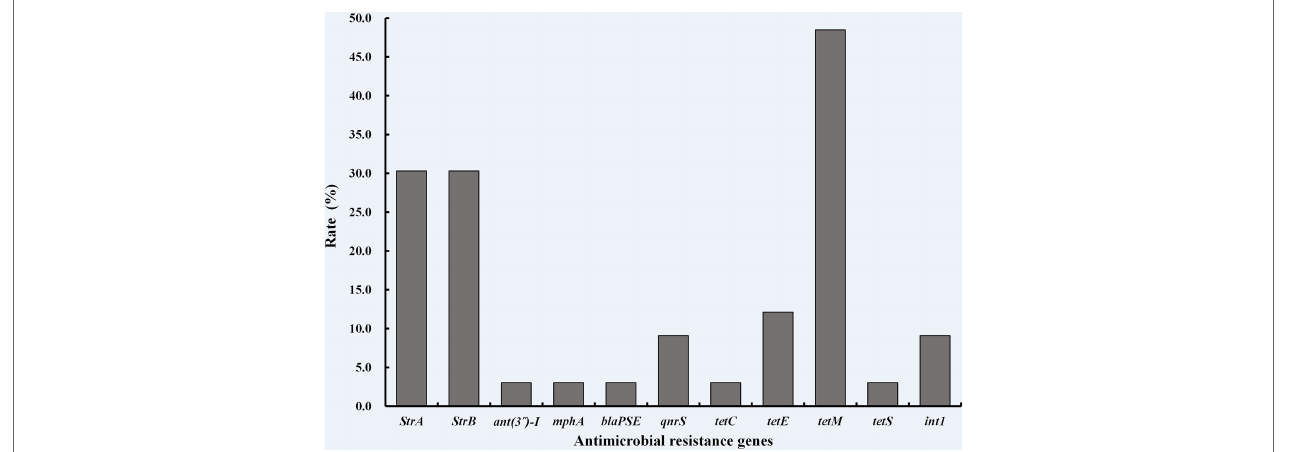
FIGURE 3 | Distribution of antimicrobial resistance genes in 33 V. scophthalmi